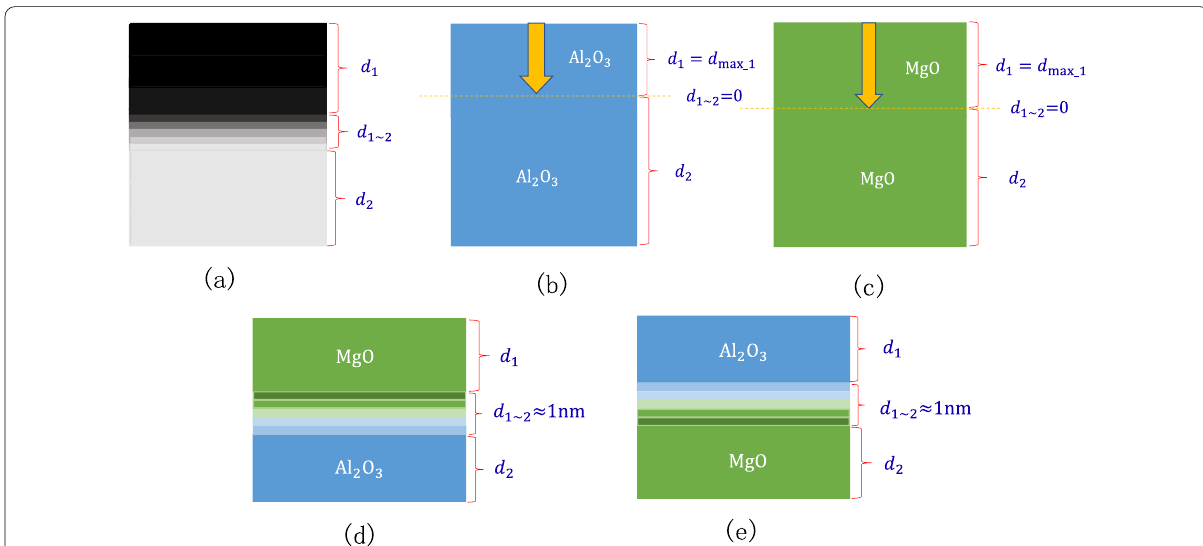
Fig. 17 a Schematic diagram of the transition layer of the double layer structure, b schematic diagram of the Al 2 O 3 transition layer and incident electron depth, c schematic diagram of the MgO transition layer and incident electron depth, d schematic diagram of the Al 2 O 3 /MgO transition layer, e schematic diagram of the MgO/Al 2 O 3 transition